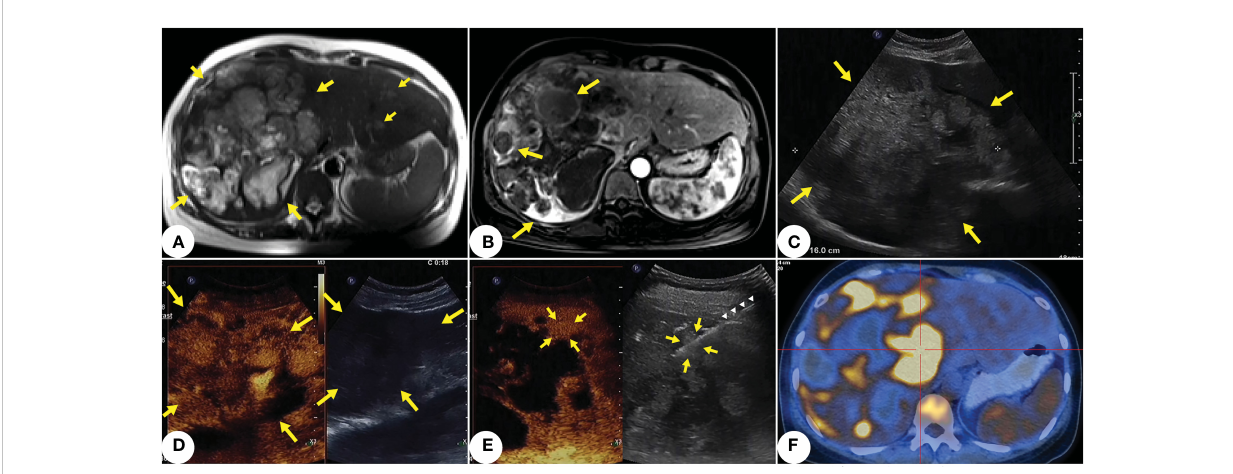
FIGURE 1 Primary hepatic angiosarcoma (PHA) in a 42-years-old woman. (A) T2-weighted axial MRI shows multiple variable-sized lesions with bright T2 signal intensity are located in both hepatic lobes. Mass lesions of PHA reveal a markedly heterogeneous architecture, with focal areas of high intensity along with septum-like or rounded areas of low intensity (indicated by yellow arrows). (B) Some lesions show annular enhancement at the edges; large masses show ruptures and hemorrhages (indicated by yellow arrows). (C) Ultrasound shows a 16cm inhomogeneous hypoechoic lesion in the right hepatic lobe (indicated by yellow arrows). Multiple masses scatter within both hepatic lobes. (D) Contrast-enhanced ultrasound shows the lesion (indicated by yellow arrows) in ill-de fi ned, peripheral irregular isoenhancement, and necrotic and hemorrhagic areas within the tumor. (E) After selecting a target lesion with multimodal enhanced imaging, (indicated by yellow arrows), we performed core needle biopsy (indicated by white triangles) under the guidance of contrast-enhanced ultrasound. (F) PET-CT shows multiple hypermetabolism lesions with retroperitoneal lymph node metastasis in the